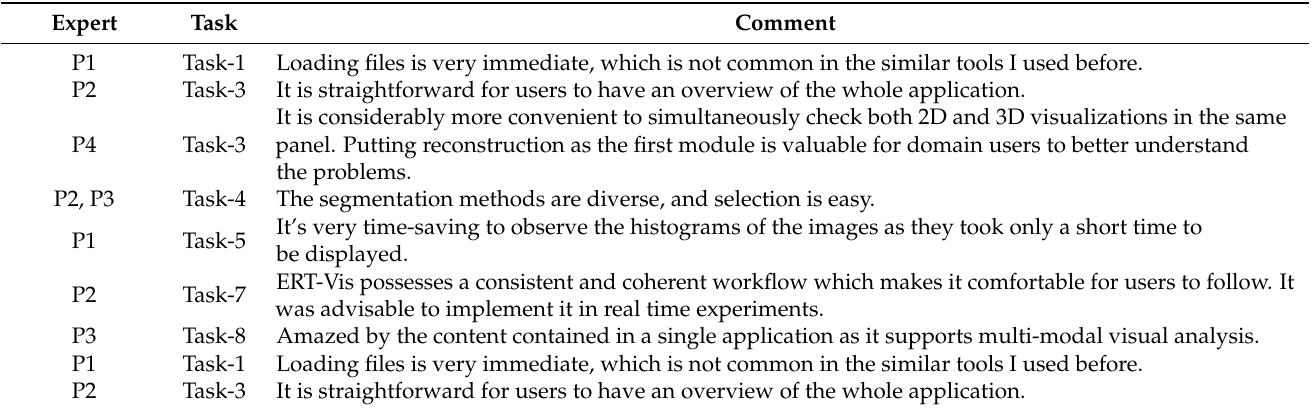
Table 3. Comments from various experts for the assigned